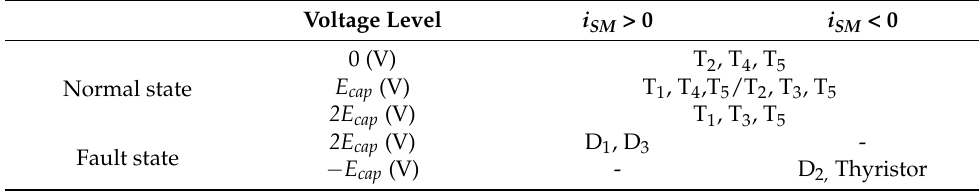
Table 1. Switch mode of the BHBSM.